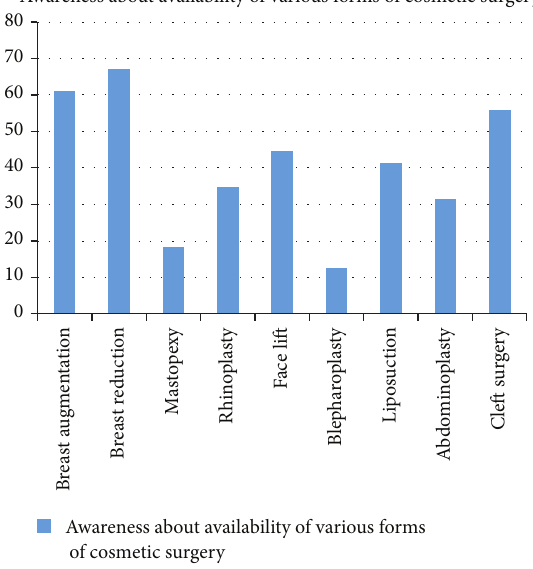
Figure 2: Awareness of respondents about cosmetic surgery.